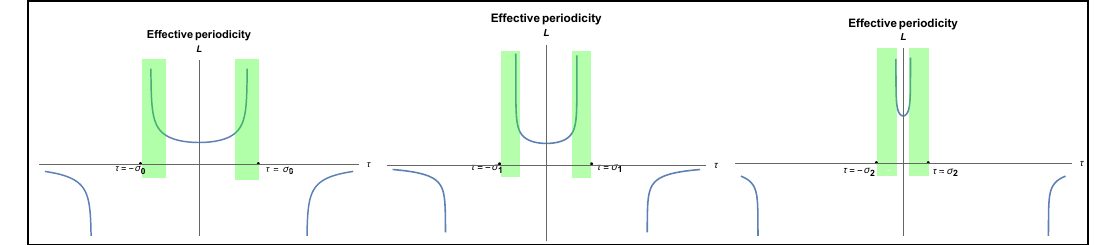
Figure 5 . Effective